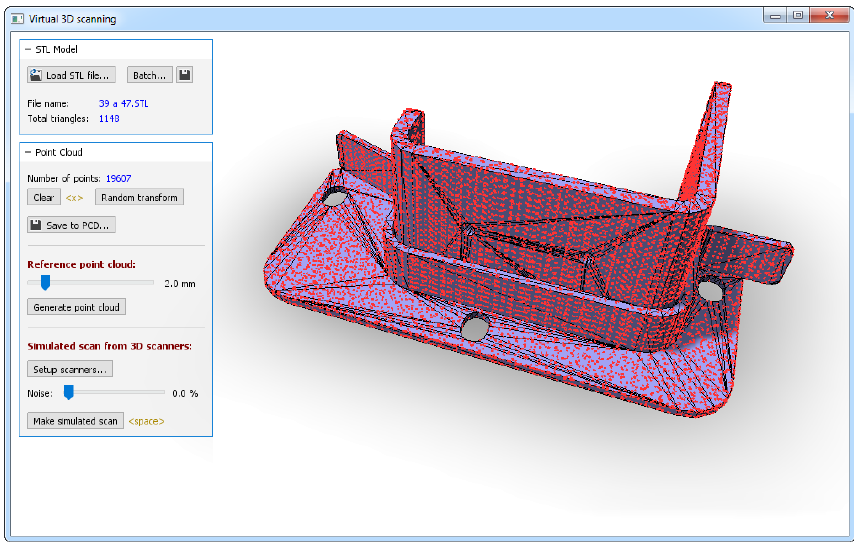
Figure 6. Screenshot of the virtual software scanner.